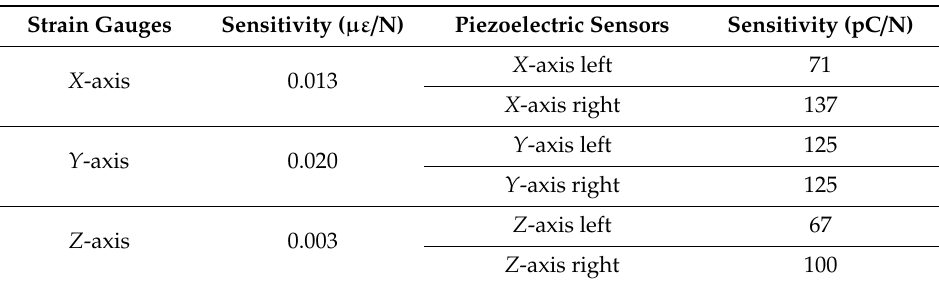
Table 3. Sensitivity Factors of the Strain Gauges and PZT Piezoelectric Sensors.